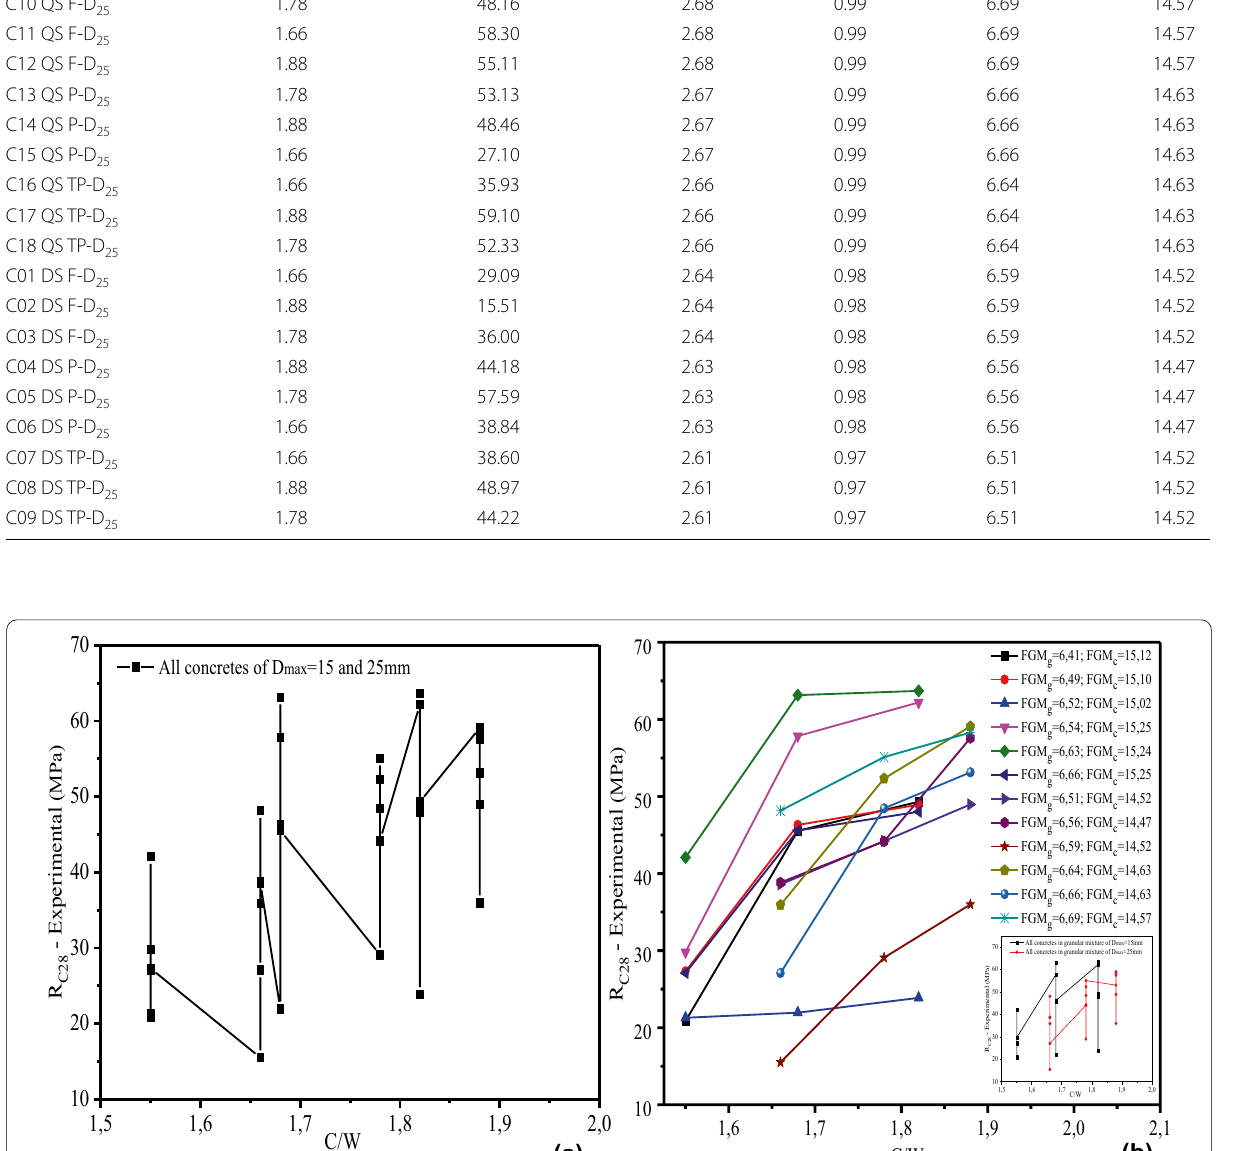
cement-to-water C / W ratio and the effect of the fractal granular model FGM g . For this, we handled the obtained graphical results by linear and exponential fittings of the D 15 and D 25 concretes results but the exponential adjust- ment proved to be more feasible than the linear one.